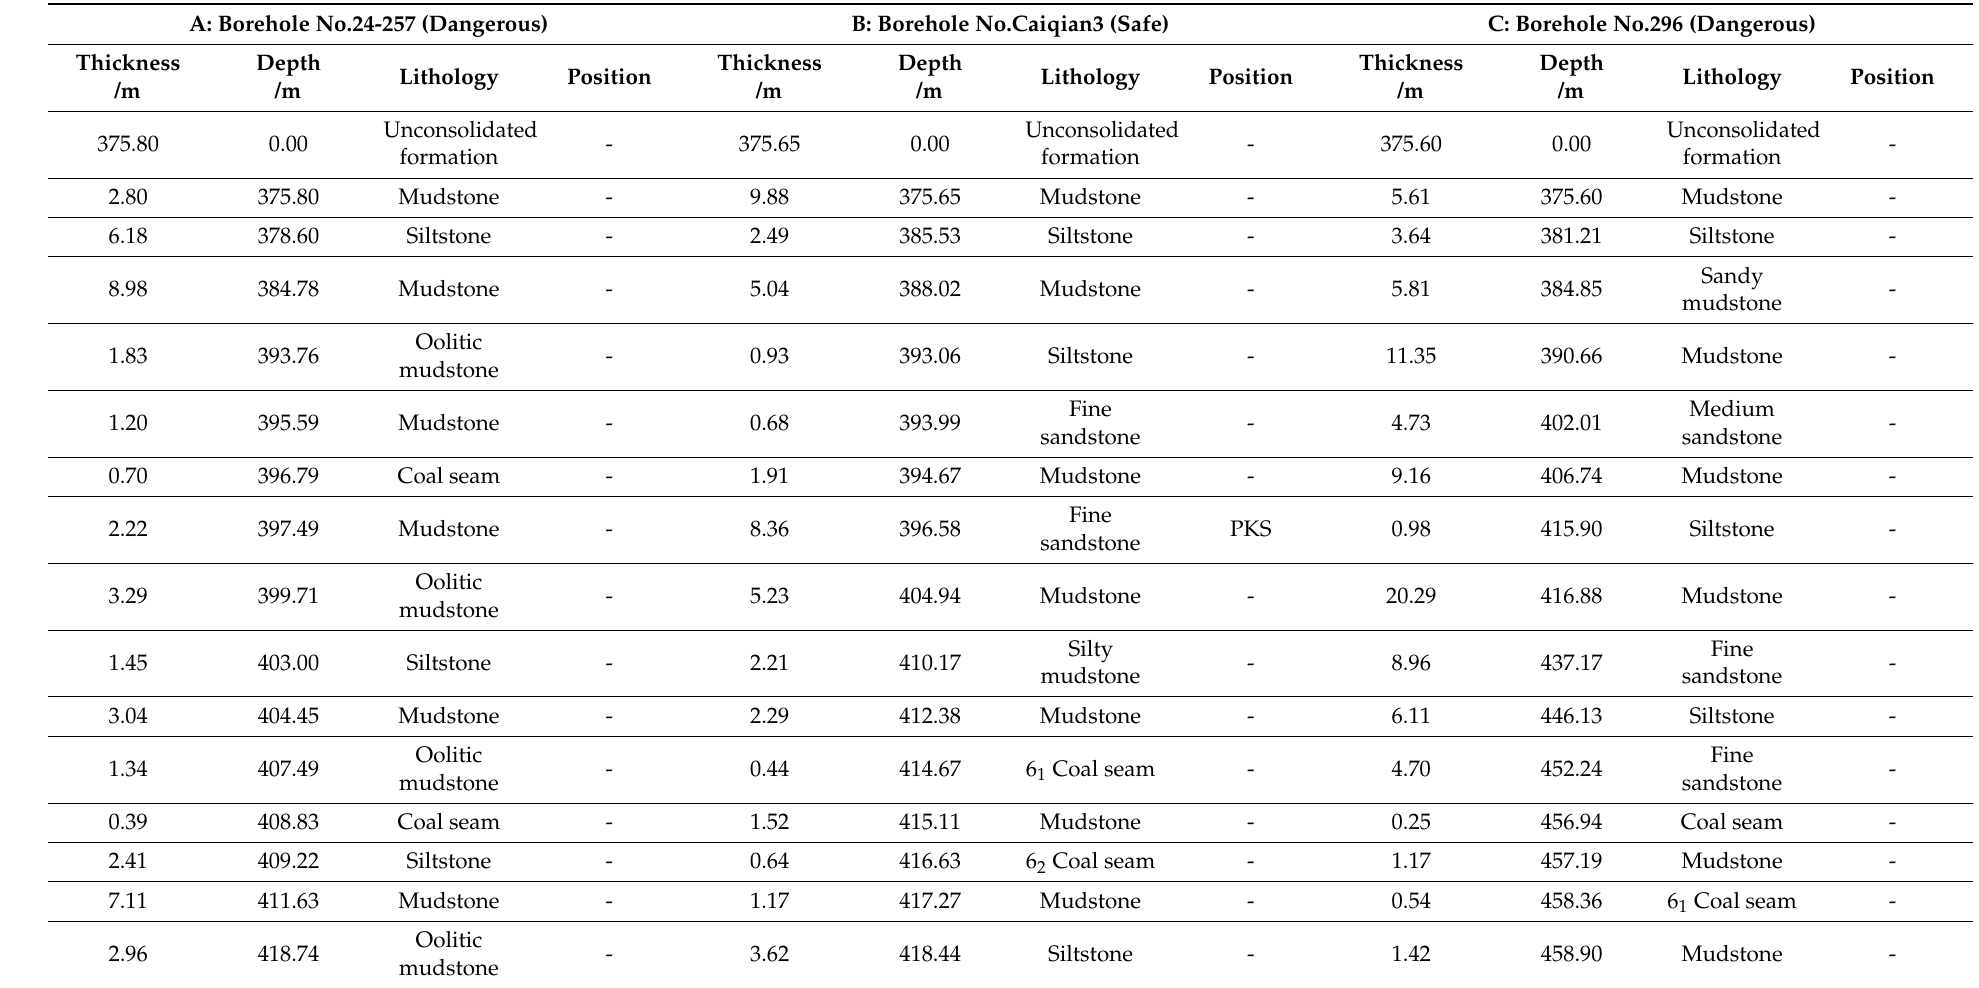
Table 3. Discrimination results of key strata location at different geological